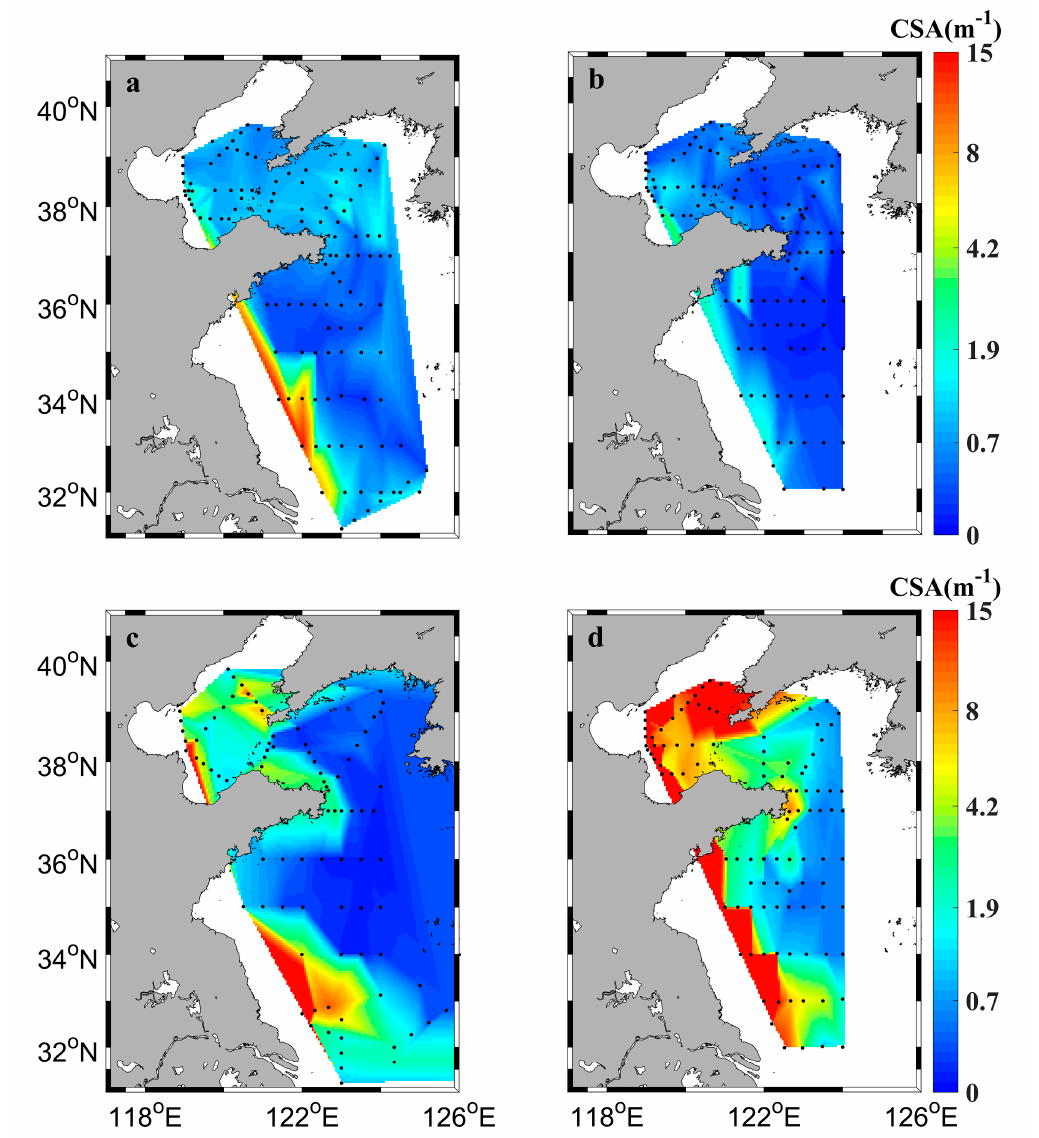
Figure 4. Cross-sectional area (CSA) distribution in the surface layer in ( a ) spring, ( b ) summer, ( c ) autumn, and ( d ) winter. The interpolation was implemented by the nearest-neighbor interpolation in Matlab (R2016a).